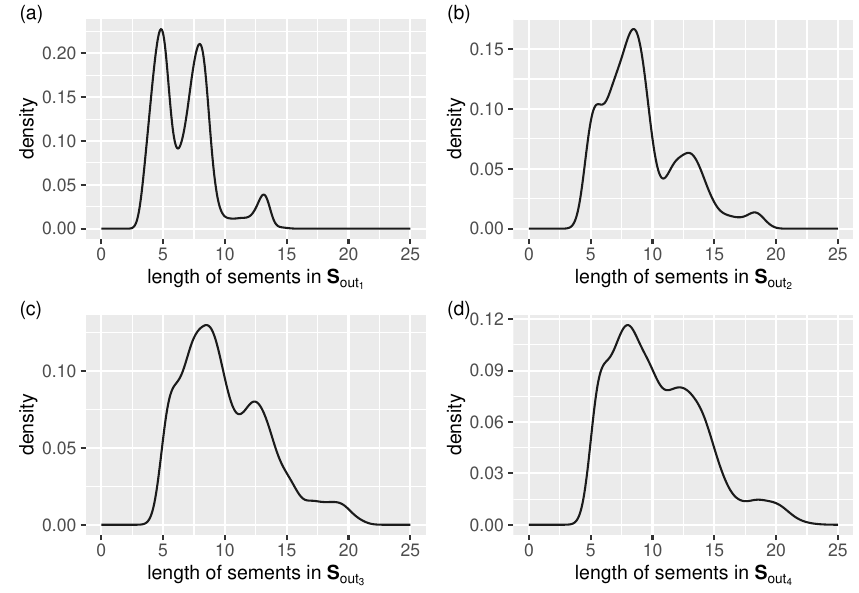
Figure 8. Output stream, S out , segment length auto-adaptation: distribution of cubic-splinelet- segment lengths (in the form of a density function) for all test streams, ( a – d ) f 1 – f 4